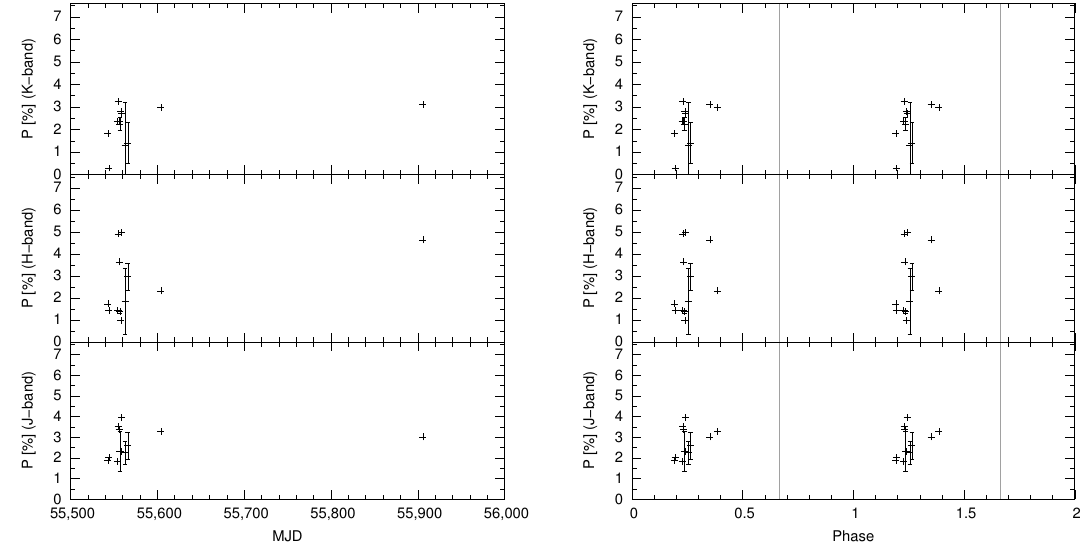
Figure 10. Liner polarization of HESS J0632 + 057 in the J -, H -, and Ks -bands with IRSF/SIRPOL. From the top to the bottom, Polarization degree in the K -, H -, and J -bands are plotted. The left and right panels show variation in time (MJD) and the orbital phase for P orb = 313 days, respectively. The two cycles are plotted in the right panel, and the vertical dash-dotted line indicates the periastron